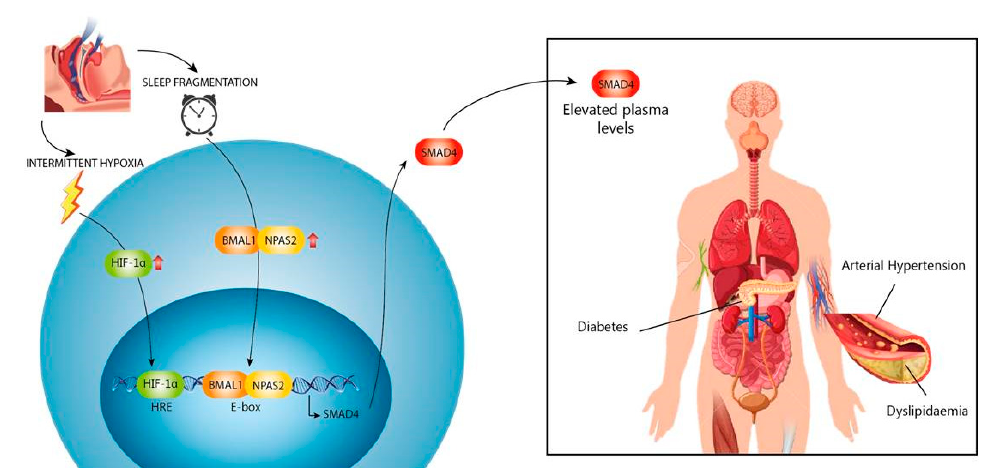
Figure 7. HIF α and mTOR are increased by intermittent hypoxia, and in combination with circadian rhythm deregulation, increase SMAD4 expression. High plasma levels of Smad4 are related to several cardiometabolic complications of OSA. Figure S1: Flow charts of included participants, Figure S2: HIF1 α and mTOR mRNA expression in in-vitro